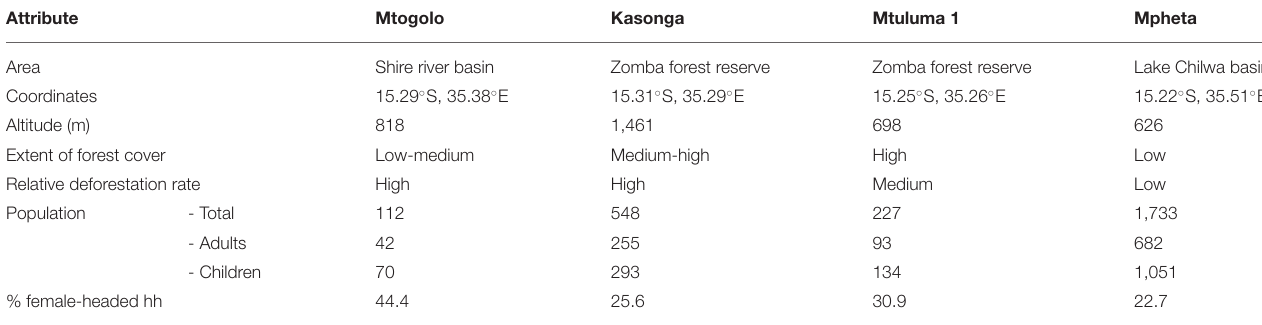
TABLE 1 | Summary characteristics of the four study